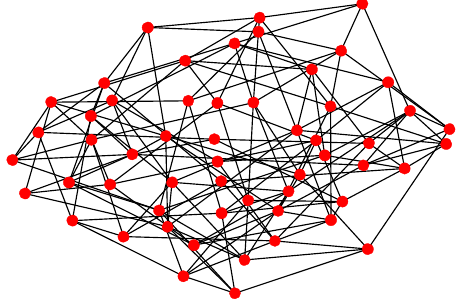
Figure 12. Communication and structure layers of Structure 3.